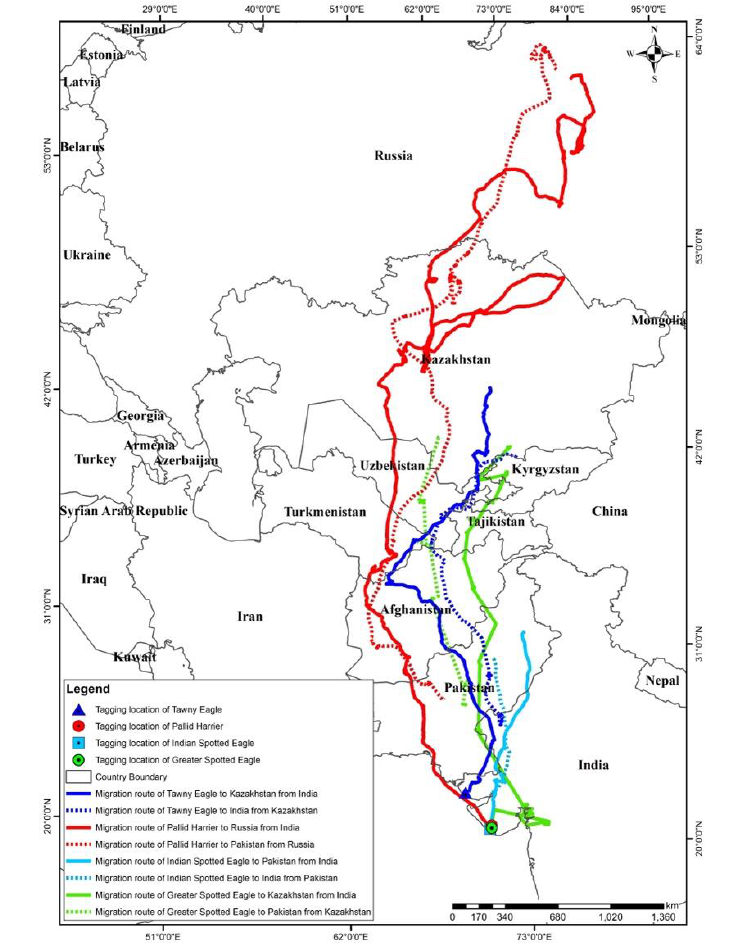
Figure 2. Migration route of tagged raptors between their wintering ground and breeding ground. Table 6. Details of the distance travelled, number of days stayed, and average elevation used during migration from wintering grounds (India) to breeding grounds (outside India) by Greater Spotted Eagle, Tawny Eagle, Indian Spotted Eagle, and Pallid Harrier fitted with satellite transmitters.